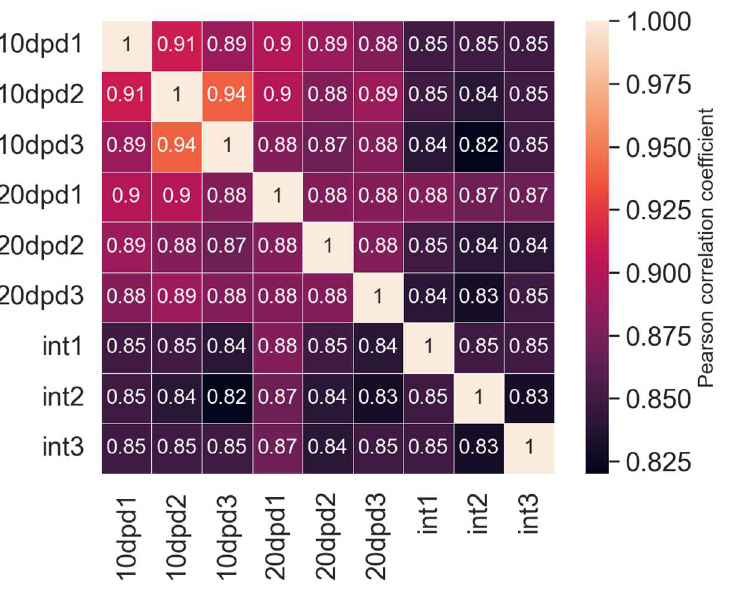
Figure 3. Correlation map of all RNA-seq samples and replicates. 10 dpd and 20 dpd—the first and second stages of regeneration, int—intact sample.